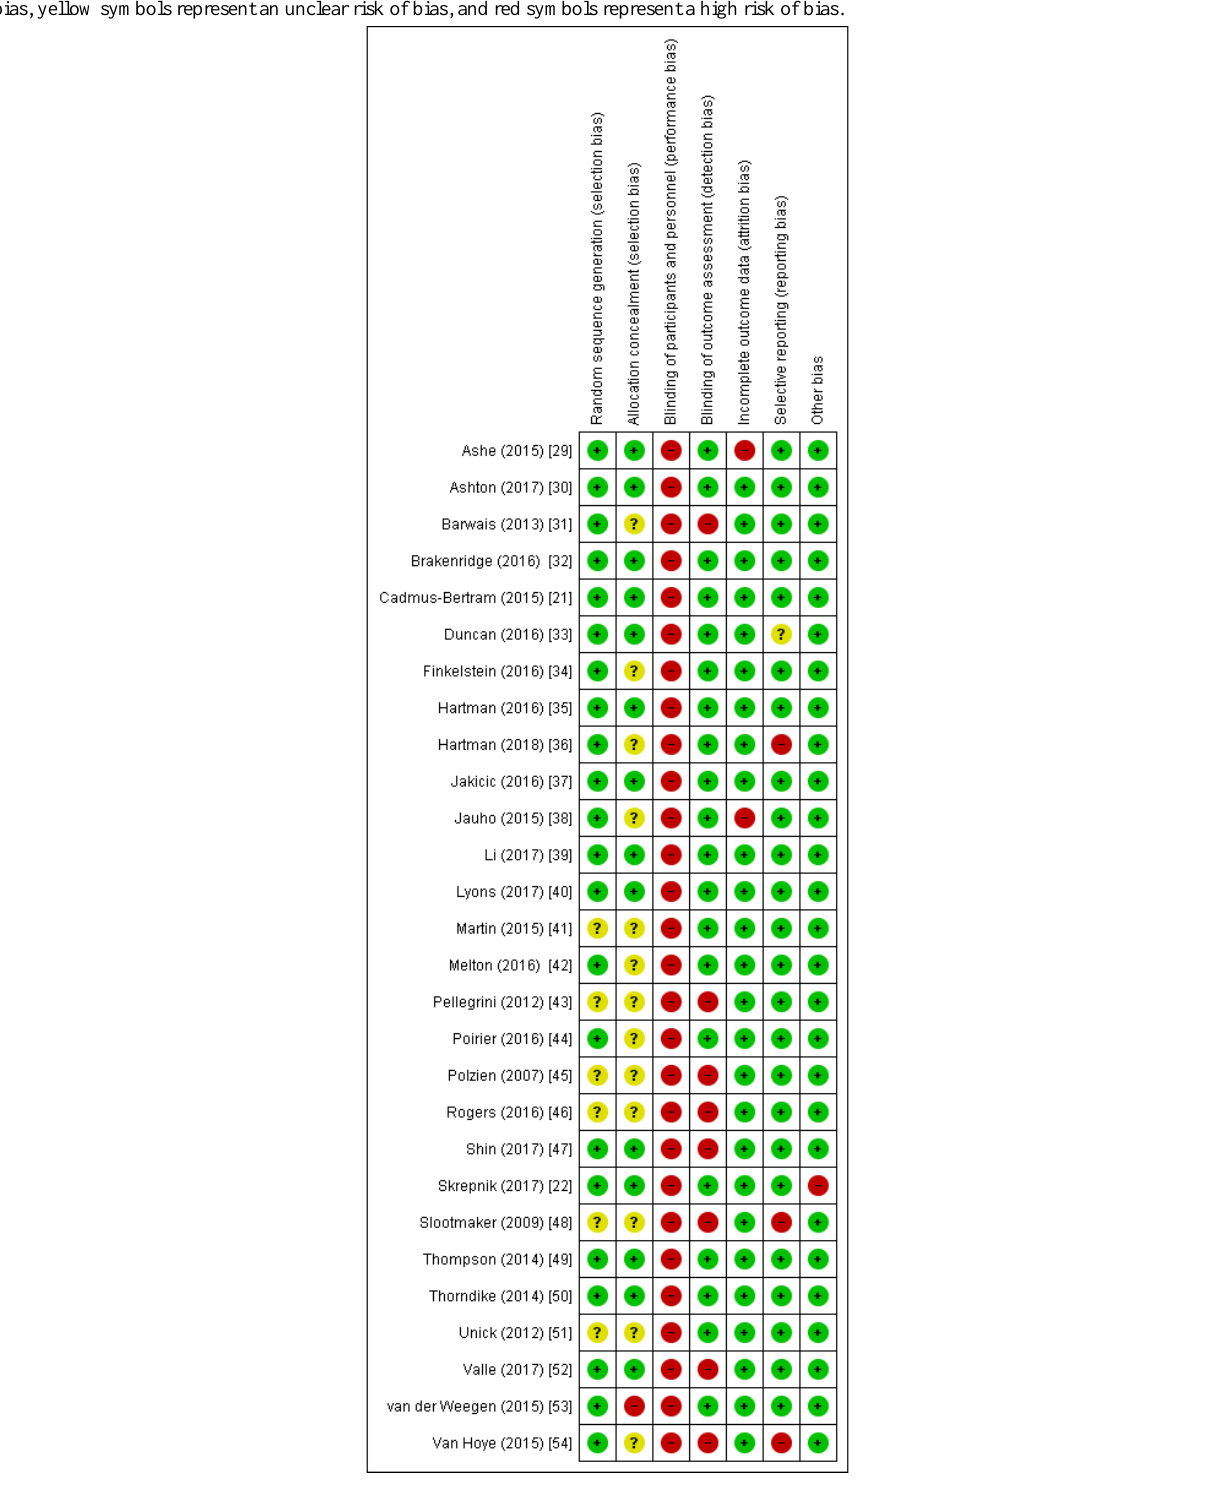
Figure 2. Risk of bias summary: review authors’ judgments about each risk of bias item for each included study. Green symbols represent a low risk of bias, yellow symbols represent an unclear risk of bias, and red symbols represent a high risk of